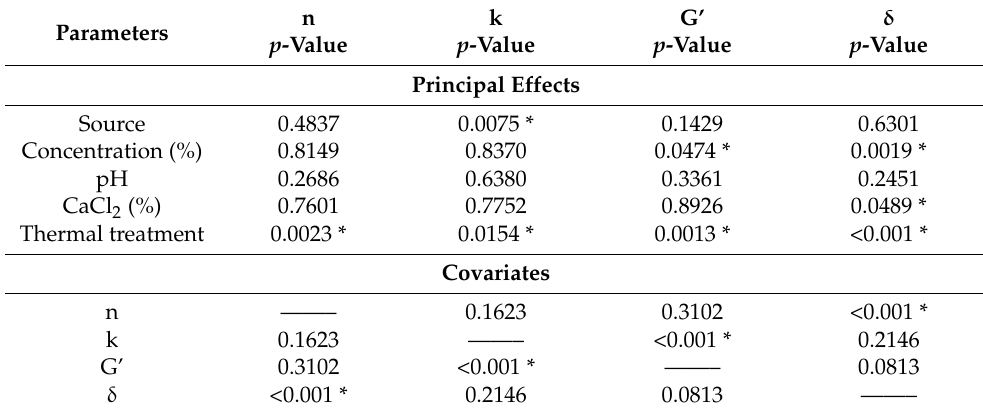
Table 2. ANOVA for the rheological